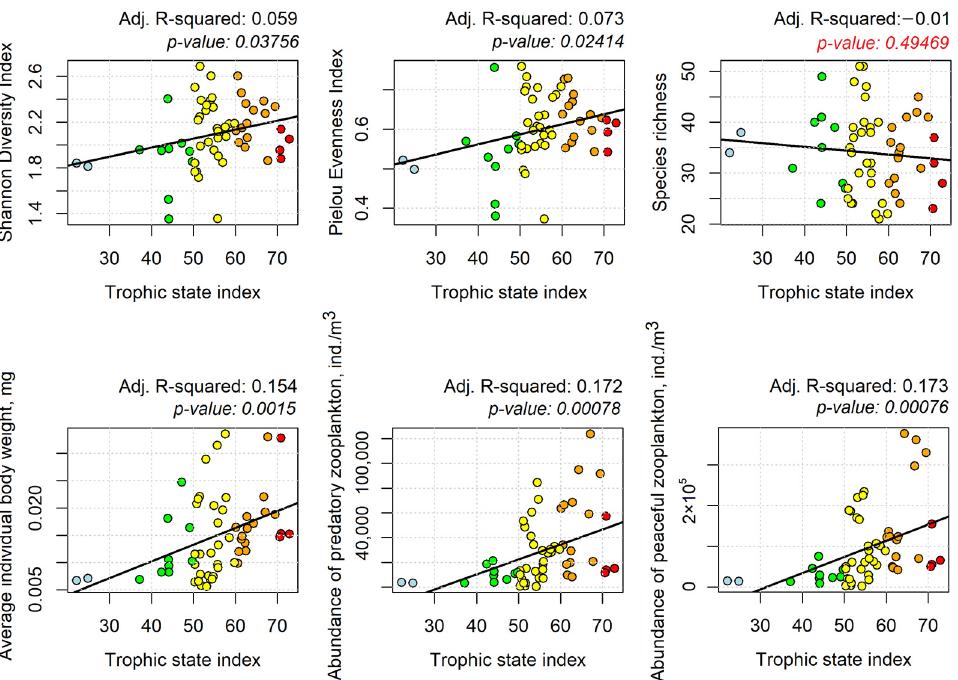
Figure 3. Scatter plots of Shannon’s Diversity and Pielou’s Evenness indices, species richness, average individual body weight for zooplankton and abundance of predatory and filtrating zooplankton in the river mouth areas; the solid line indicates the linear regression, color-coding means trophic status (blue—oligotrophic, green—mesotrophic, yellow—slightly eutrophic, orange—medium eutrophic, red—highly eutrophic).